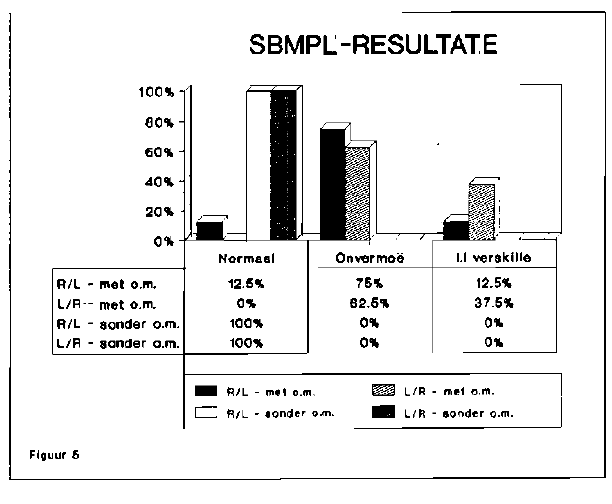
Figuur 5: Resultate van die SBMPL-toets